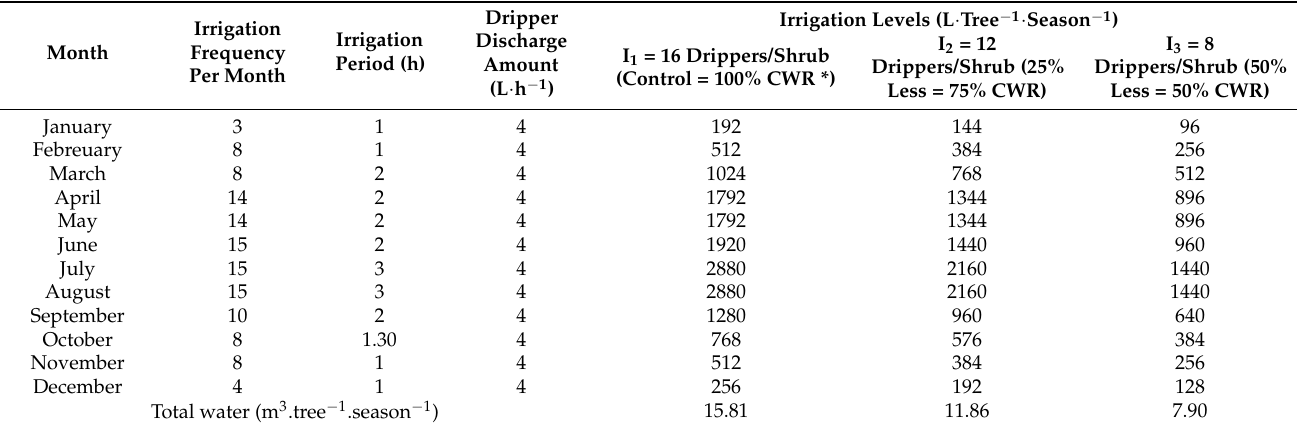
Table 3. Quantity of the irrigation water applied during the 2019 and 2020 seasons.